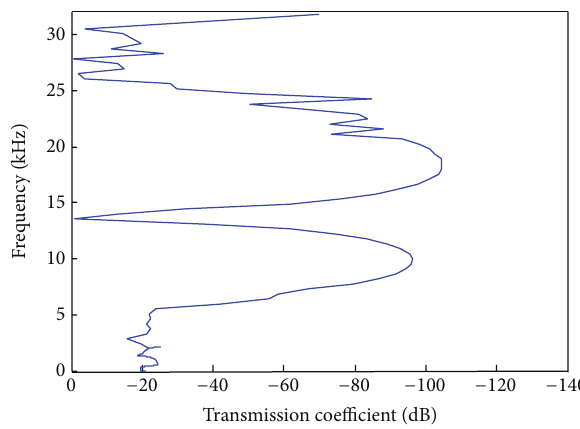
Figure 10: Transmission characteristics of phononic crystal